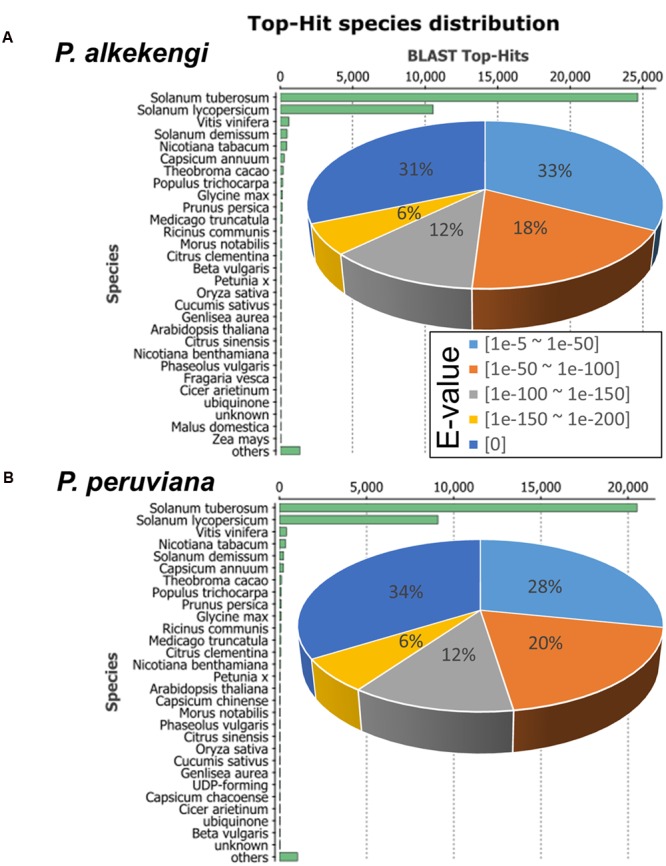
Characterization of the assembled unigenes based on a non-redundant (NR) protein database search in Physalis. (A) Top-hit species- and E-value-distributions of P. alkekengi. The E-value distribution of BLAST hits for the assembled unigenes with a cutoff of E-value < 1E-5. (B) Top-hit species- and E-value-distributions of P. peruviana. Top-hit distribution was calculated based on only the best/top sequence alignment with the lowest E-value for our BLAST result.